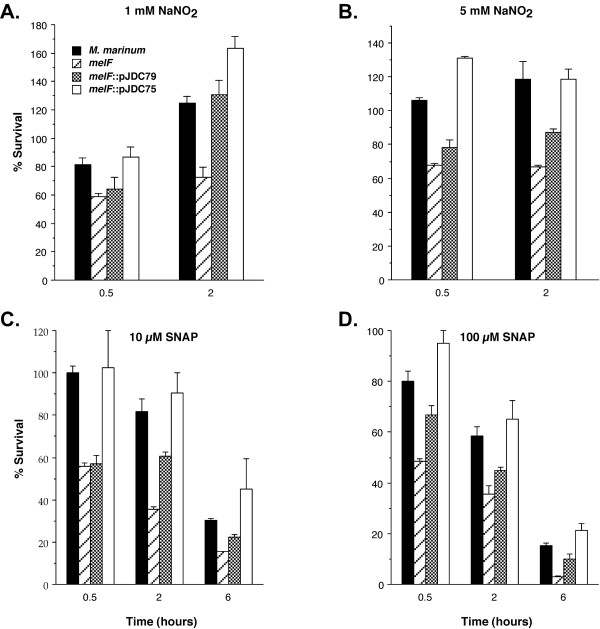
Susceptibility of the mel2 mutant to reactive nitrogen species. Susceptibility of M. marinum wild type as compared to the mel2 mutant that carries an insertion in melF (melF), the mutant carrying a plasmid expressing melF alone (melF::pJDC79) and an integrated single copy plasmid expressing the entire mel2 locus (melF::pJDC75) to 1 mM (A) or 5 mM (B) sodium nitrite (NaNO2) and 10 μM (C) or 100 μM (D) S-nitroso-N-acetyl penicillamine (SNAP). The % survival = (CFU Tx/CFU initial) × 100. Data are the means and standard deviations of assays done in triplicate, representative of three experiments.